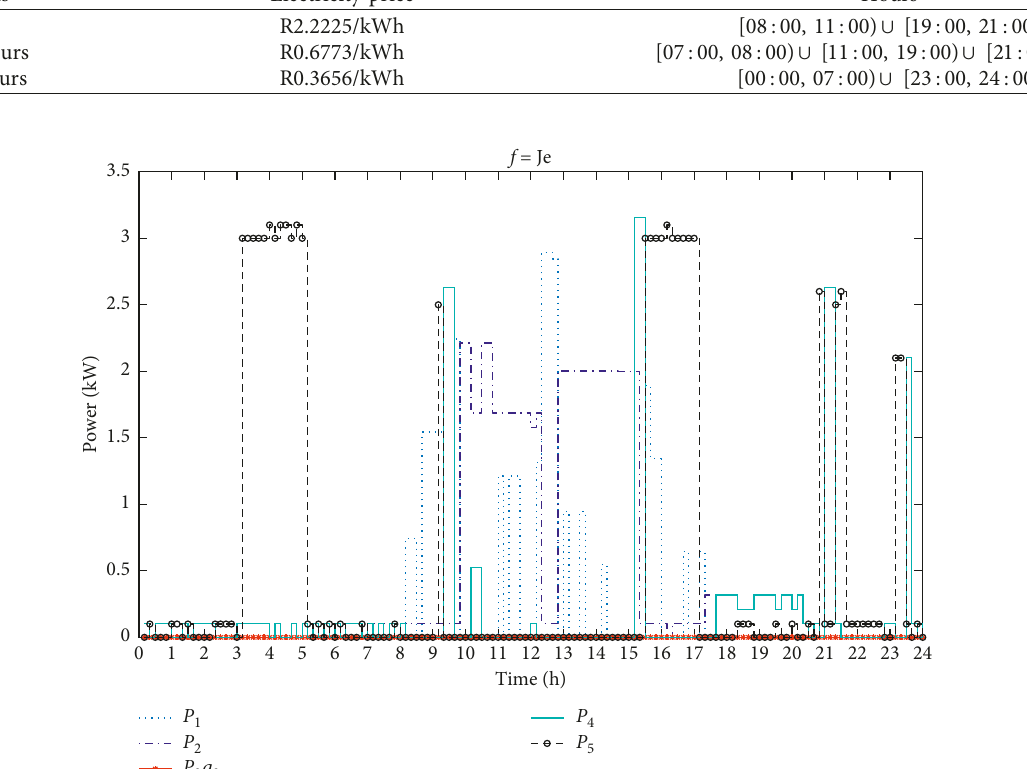
Figure 3: Power dispatch of the new design in case